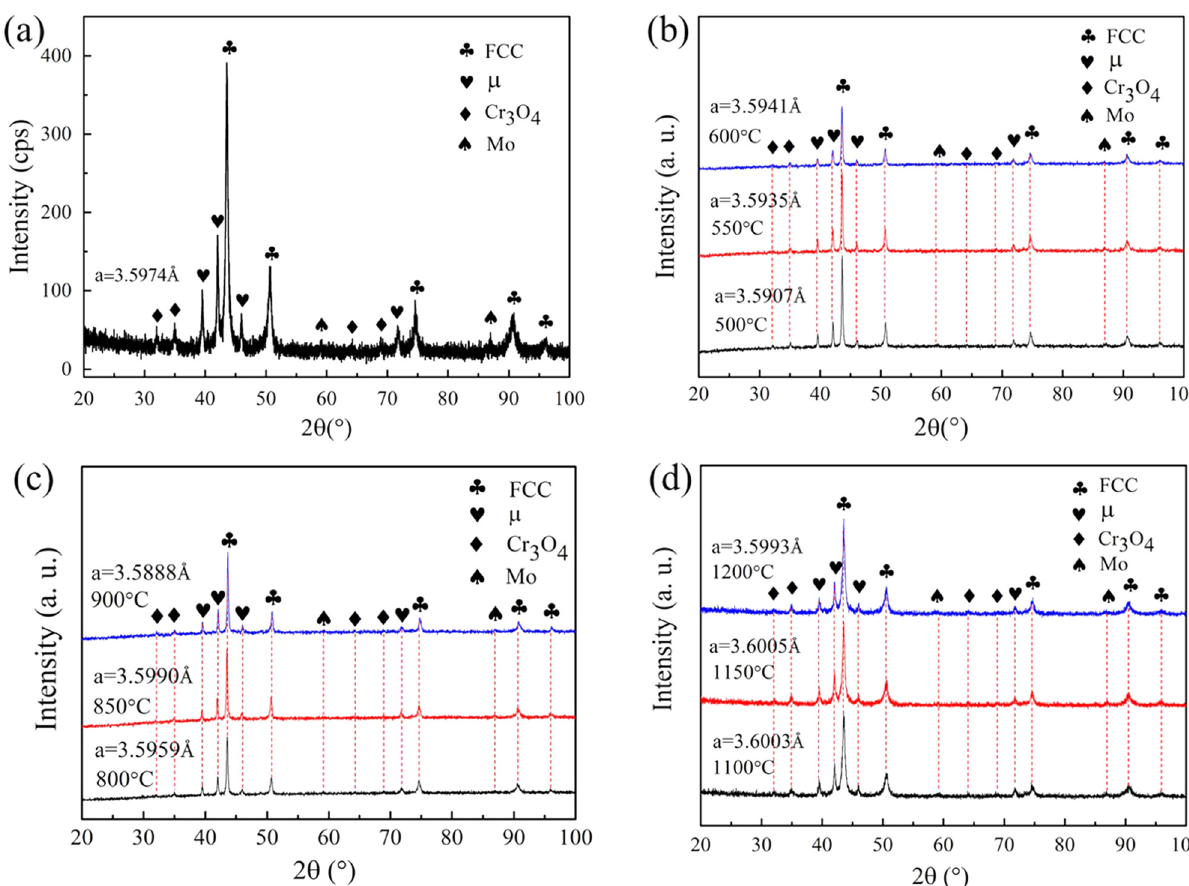
Figure 4: The XRD patterns of as - sintered and as - annealed alloys: ( a ) N - HT alloy, ( b ) L - 50 alloy; L - 55 alloy; L - 60 alloy, ( c ) M - 80 alloy; M - 85 alloy; M - 90 alloy, and ( d ) H - 110 alloy; H - 115 alloy; H - 120